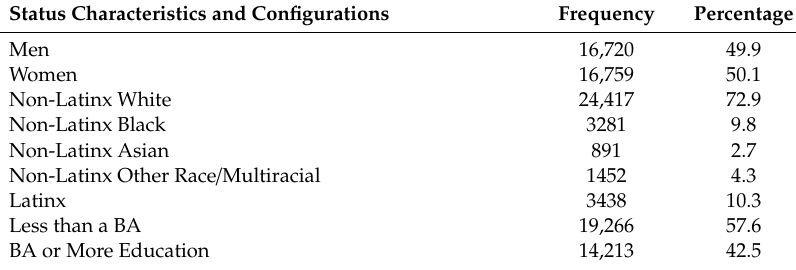
Table 1. Frequency and percentage of status